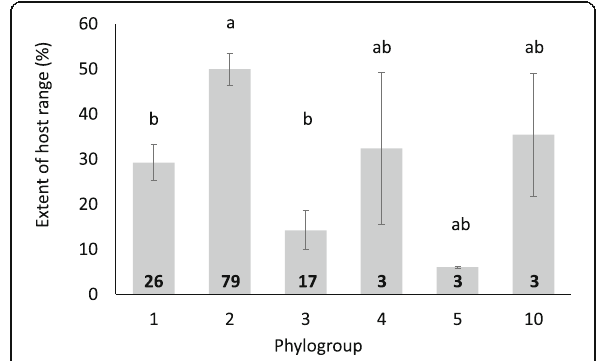
Fig. 5 Extent of host range of the strains in different phylogroups of Pseudomonas syringae . Host range is expressed as the mean of the percent of plant species in each test on which strains in a given phylogroup were virulent (caused symptoms on at least half of the replicate plants). The number of strains tested in each phylogroup is indicated in boldface. Only phylogroups for which more than 2 strains were tested are presented here. Error bars represent standard error of the means. Means associated with the same lower case letter are not significantly different based on pair-wise comparisons (Tukey ’ s Honest Significant Difference Test, P < 0.05)